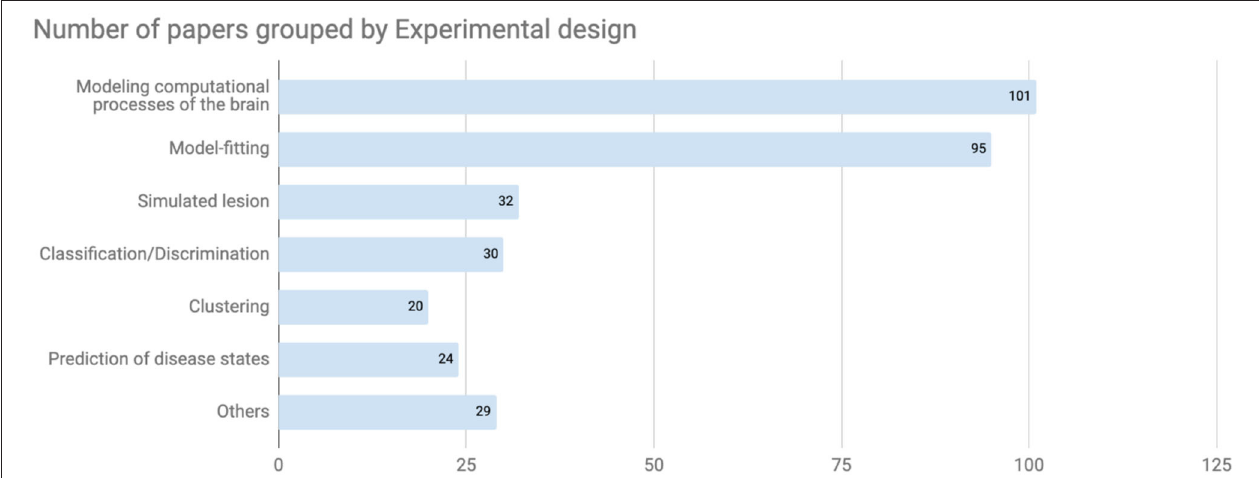
FIGURE 4 | Number of papers grouped by experimental design. In terms of experimental design from the computational perspective, both modeling computational processes of the brain and model-fitting were frequently used in the registered CPSY papers.